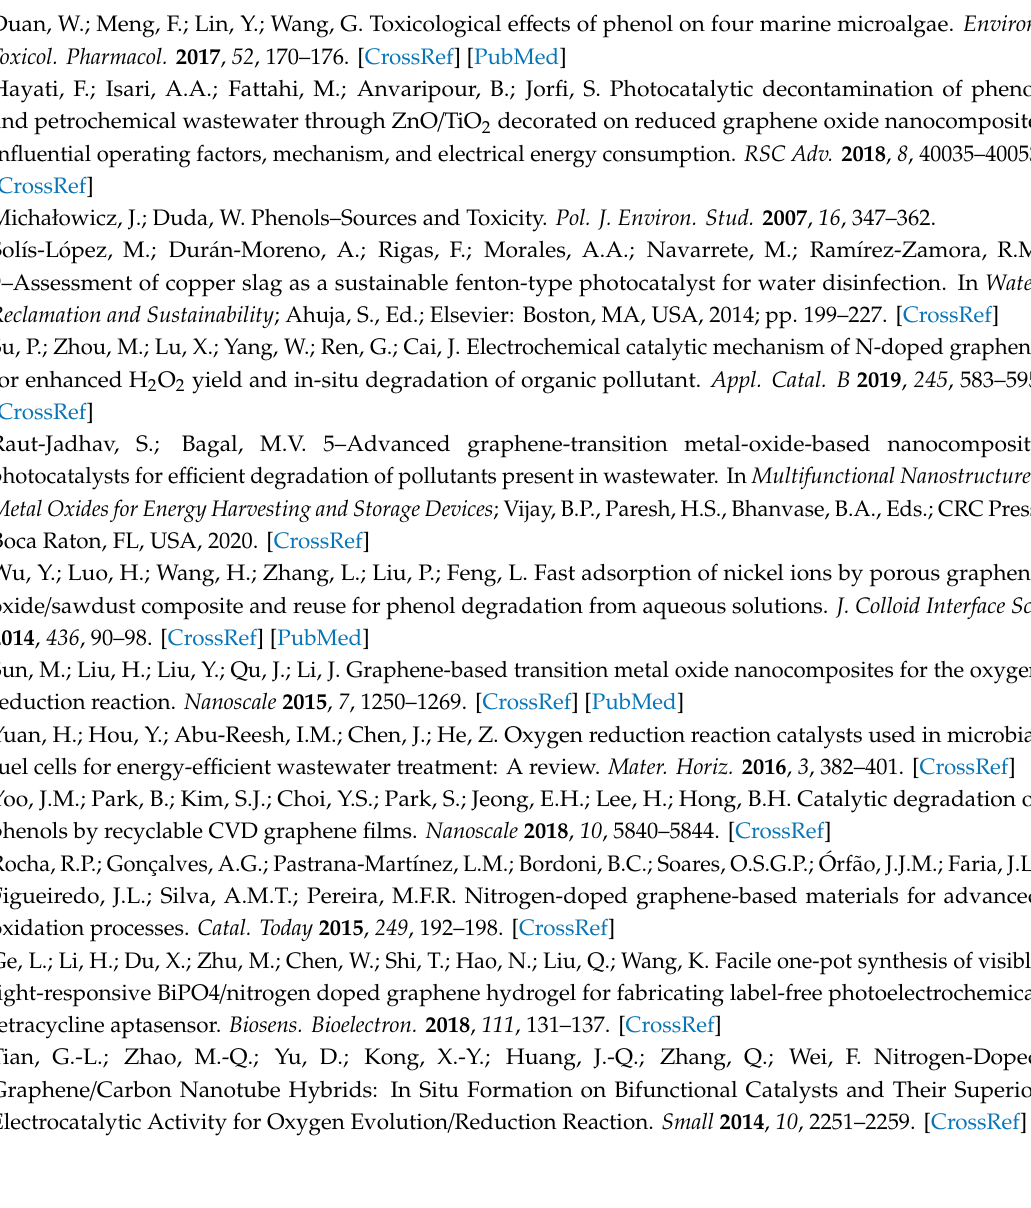
Figure S1: The intensity of UV light’s illumination a ff ects the extent of phenol degradation, Figure S2: Comparison of the graphene’s catalytic e ff ect on Fenton’s reagent, Figure S3: Adhesion of phenol on graphene or PI surface does not significantly reduce the phenol concentration, Figure S4: Graphene transferred on PI film still exhibits the catalytic e ff ect, Figure S5: The e ff ect of temperature on phenol degradation, Figure S6: The two-column system for the improvement in degradation e ffi ciency, Figure S7: The AOP intermediates detected when using graphene and Fenton’s reagent, Video S1: Continuous degradation of phenol using the CVD graphene